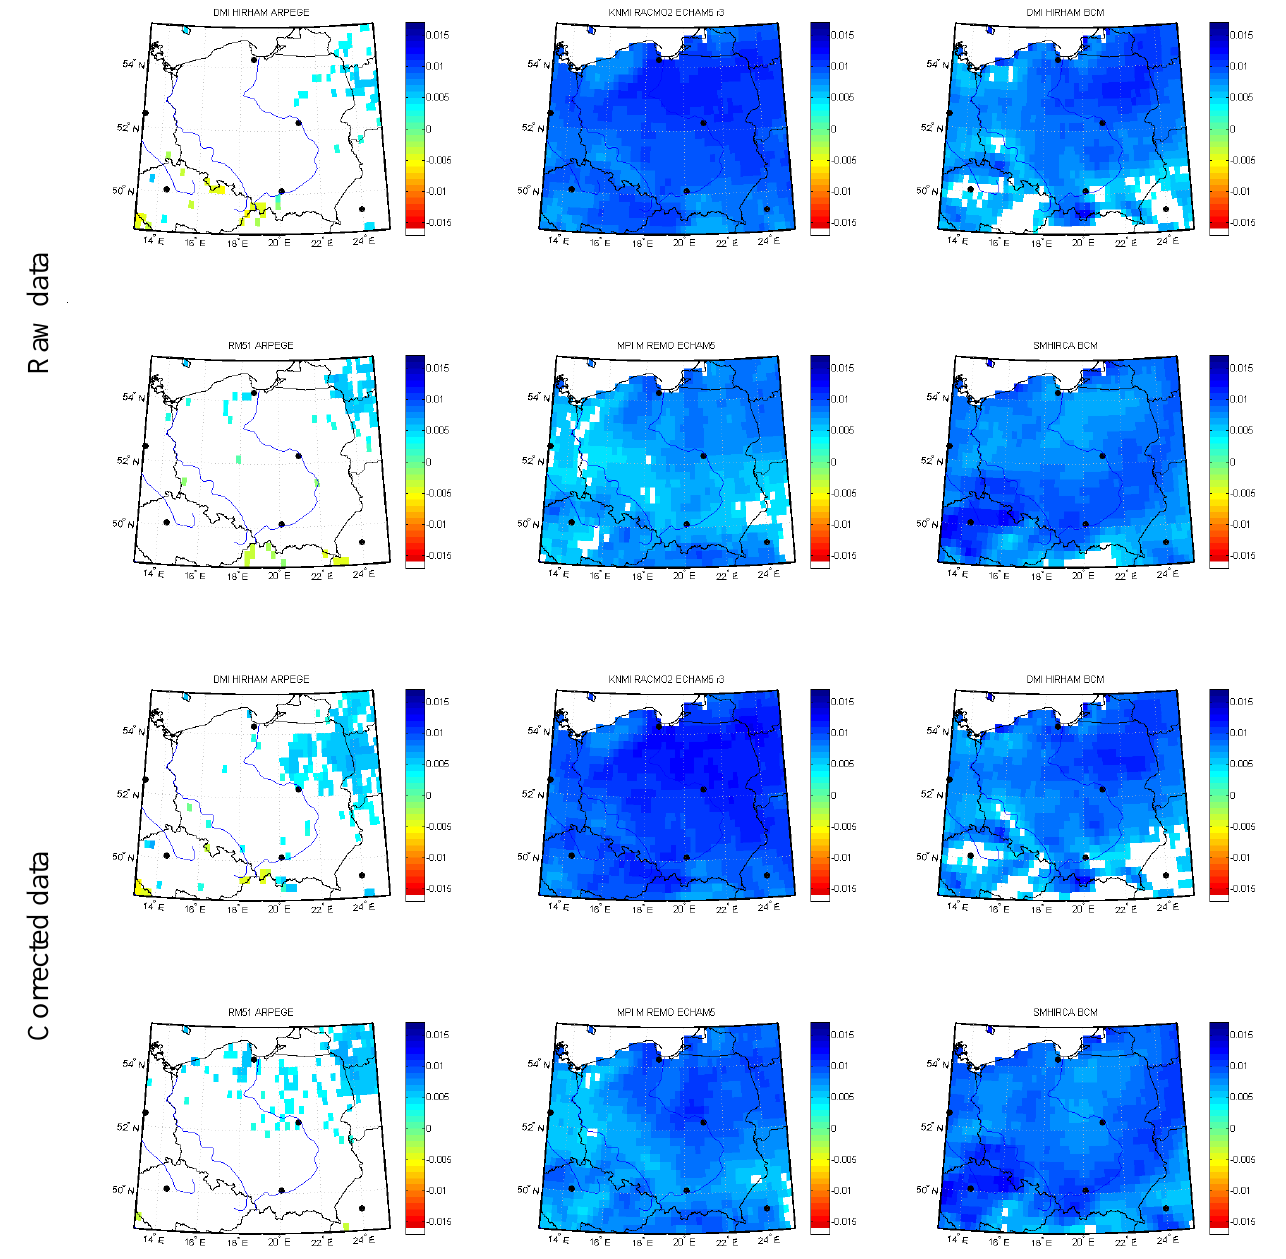
Figure 11. Results of the trend estimation using the Mann–Kendall method for the SPI 3 for the winter season (DJF). Colour scale denotes slope of the estimated trend. White colour denotes lack of statistically significant